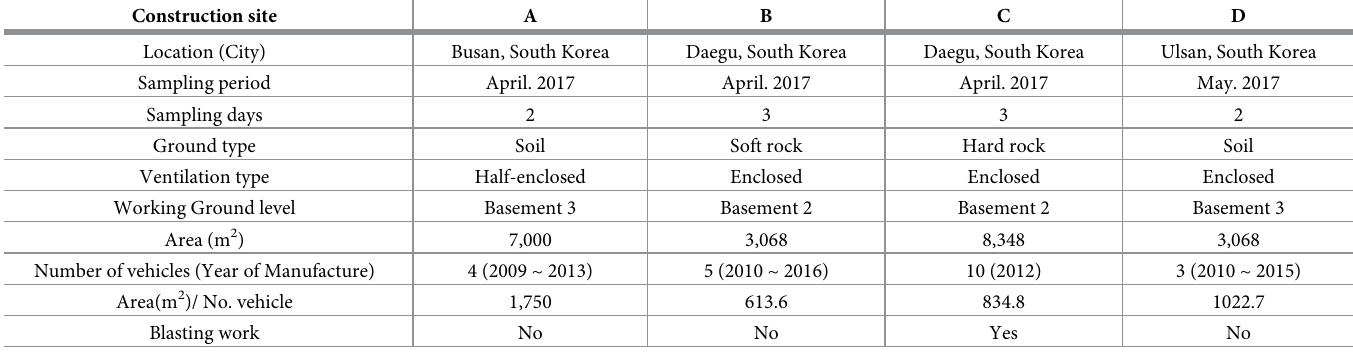
Table 1. Target monitoring